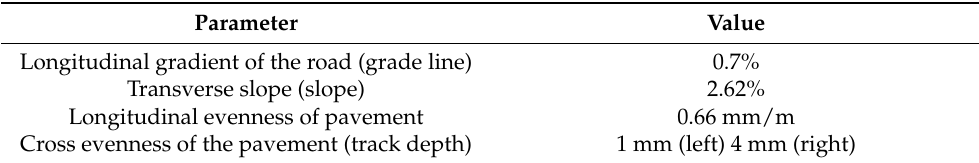
Table 3. Pavement parameters.